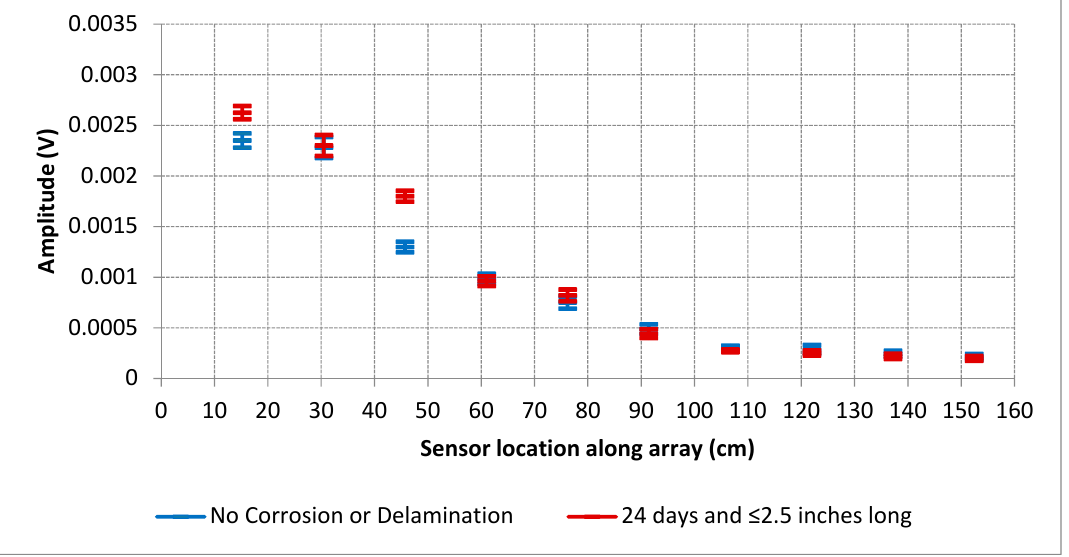
Figure 12. Corrosion and delamination test—Rebar 3: Transmitter located on the corrosion end and receiver array on the concrete edge 30.48 cm (1 ft) away from the wave guide.